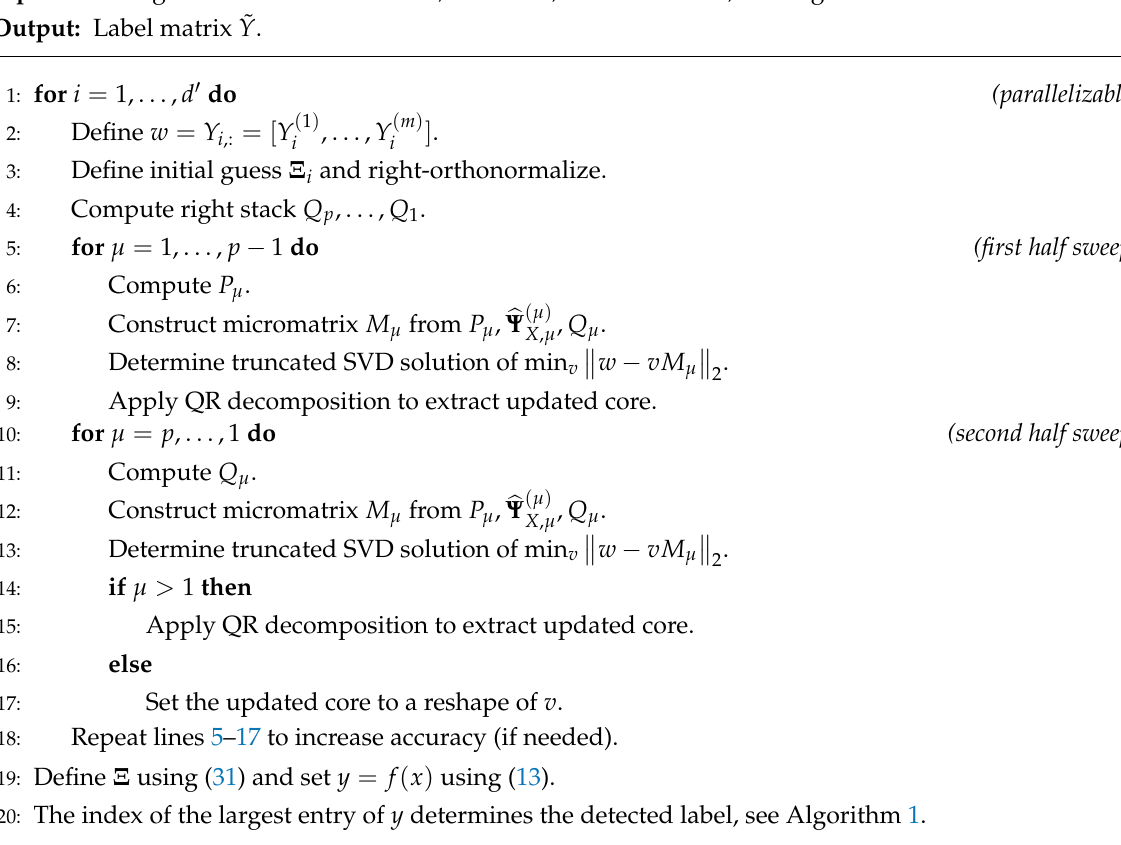
Algorithm 2 Alternating ridge regression (ARR) for